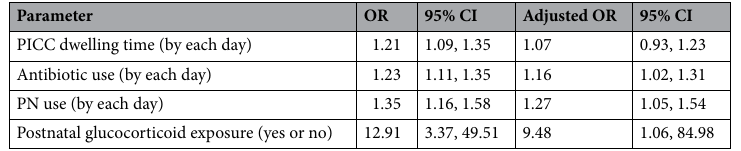
Table 3. Logistic regression analysis for fungal colonization at the catheter tips. The duration of PN and PICC dwelling time were entered into the logistic regression model only one parameter at a time. OR odds ratio, CI confidence interval, PICC peripherally inserted central catheter, PN parenteral nutrition.